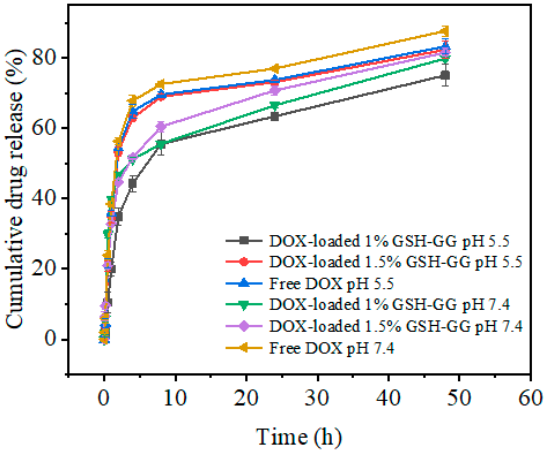
Figure 4. The drug release of free DOX and DOX-loaded GSH-GG under different conditions.